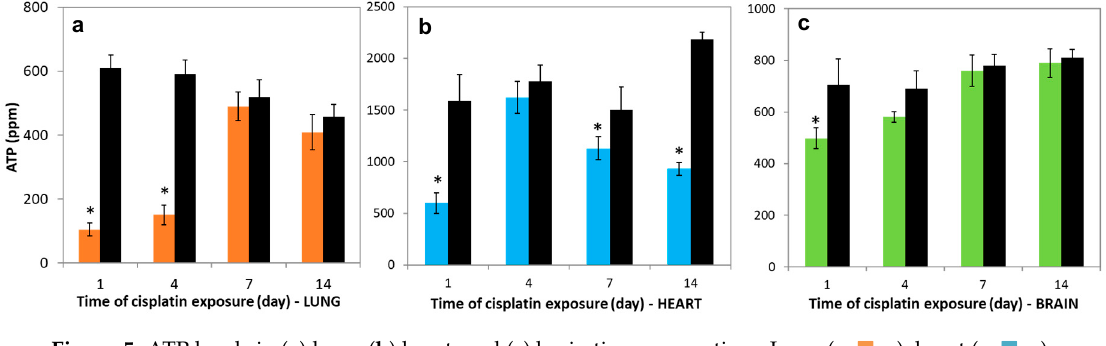
Figure 5. ATP levels in ( a ) lung, ( b ) heart, and ( c ) brain tissues over time. Lung ( ⎯ ⎯ ), heart ( ⎯ ⎯ ), and brain ( ⎯ ⎯ ) tissue of treatment group, and controls ( ⎯ ⎯ ). Results are expressed as mean ± SD ( n = 6). *Significantly different ( p < 0.05) from control.